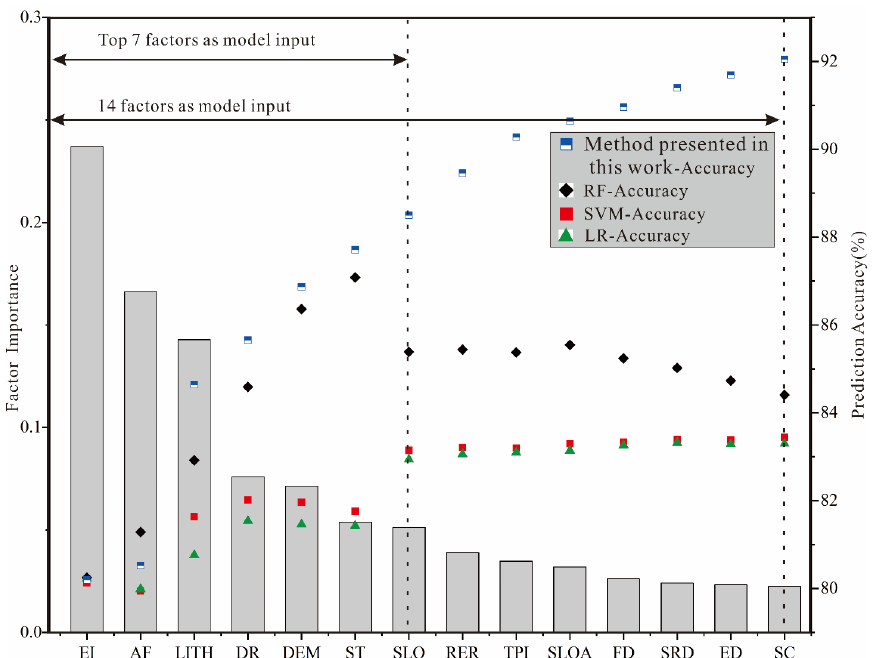
Figure 12. Controlling factor importance and prediction accuracies of different models. The predic- tion performance of all methods improved with the increasing number of input-controlling factors; however, the performance of the shallow machine learning model then decreases or remains stable when low-value density data are input, except for the method presented in this